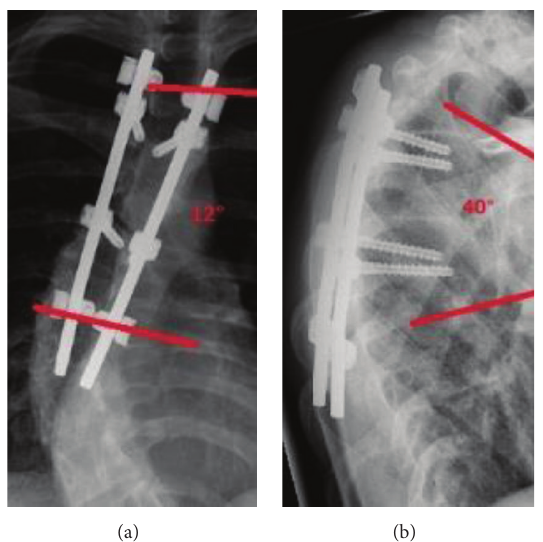
Figure 2: (a) Postoperative result in ap view with pedicle screws in T4 and T6 and UC System in T3 and T7 (12 months). Cobb angle (T3–7): 12 ∘ . (b) Postoperative result in lateral view (12 months). Kyphosis angle (T3–7): 40 ∘ .